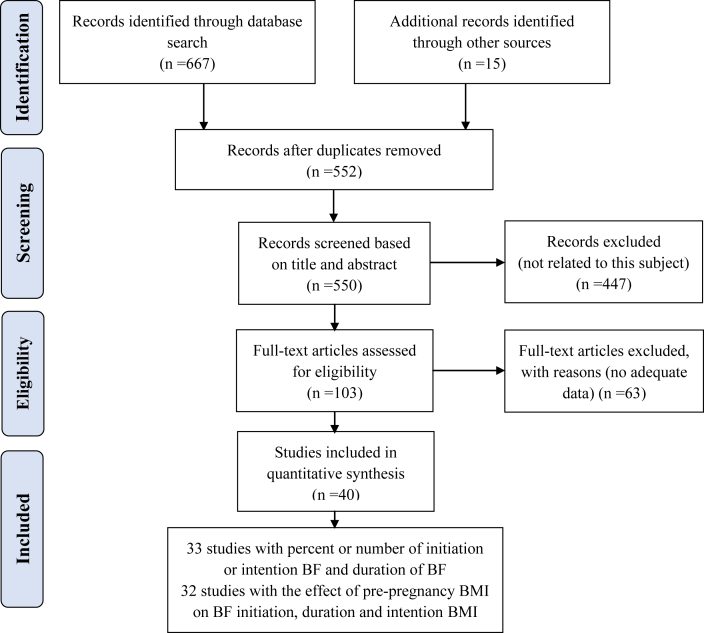
Flow diagram of the study selection process and including publications for the dose-response meta-analysis of pre-pregnancy BMI and breastfeeding initiation, intention and duration.